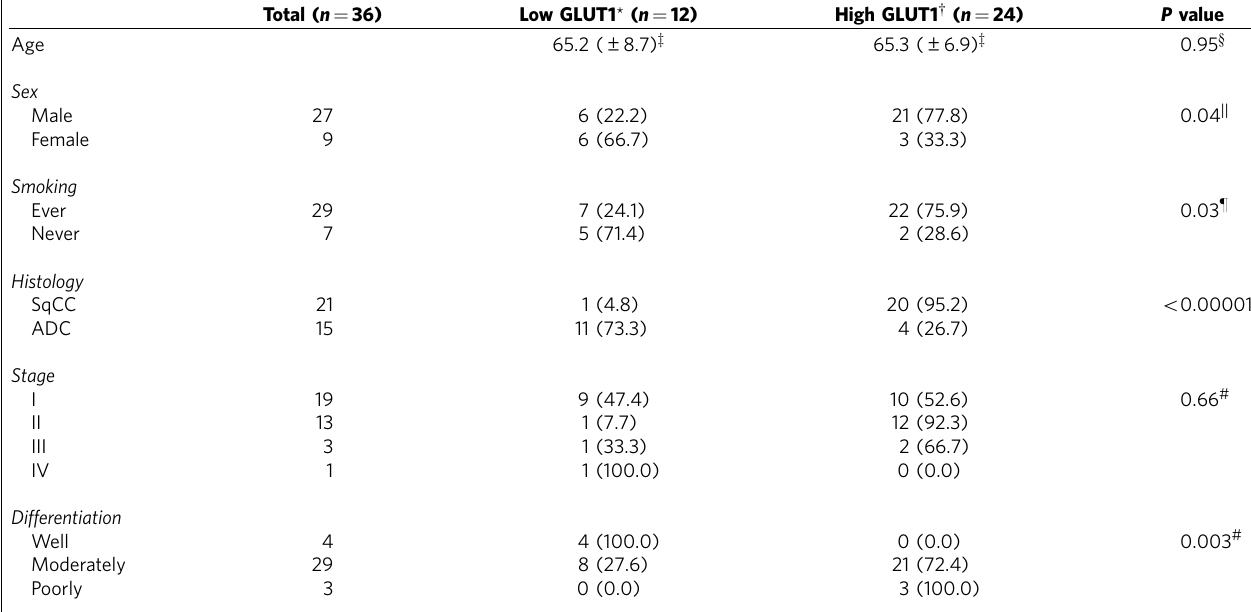
Table 1 | Clinical characteristics of patients by GLUT1